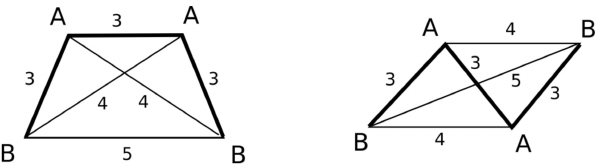
Figure 4. Trapeze-like and parallelogram-like pharmacophore quadruplet belonging to AABB class and not distinguishable by graph canonical